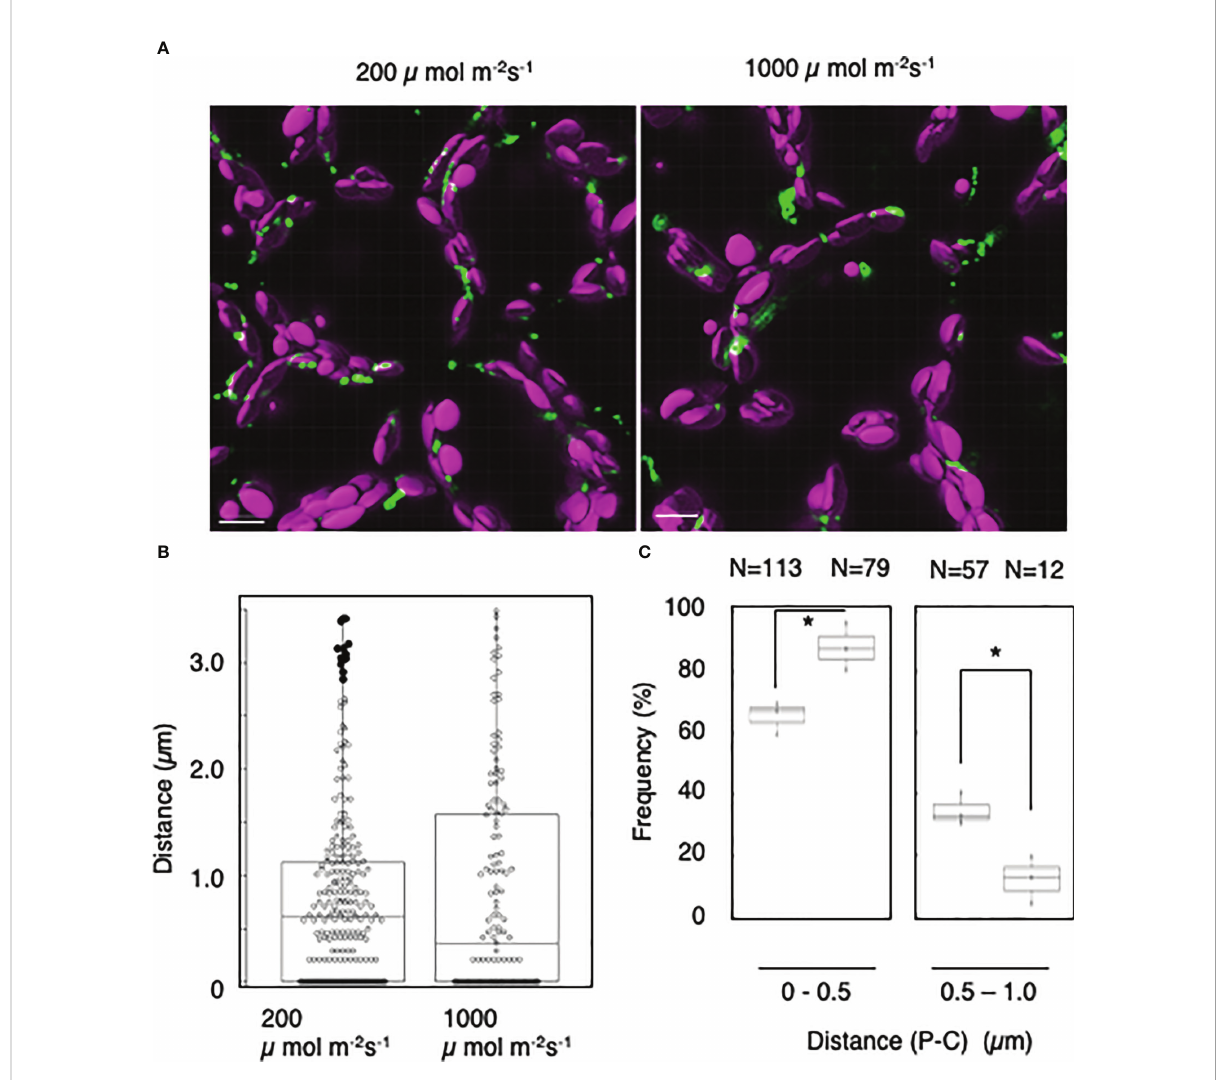
FIGURE 5 Measurement of the distances between chloroplasts and peroxisomes in leaf mesophyll cells under high-light conditions. (A) Representative images of chloroplasts (magenta) and peroxisomes (green) in leaf mesophyll cells adapted to low-intensity (200 µmol m − 2 s − 1 , left) and high- intensity (1,000 µmol m − 2 s − 1 , right) light for 2 h. Bars, 10 µm. (B) Box plots of the distances between peroxisomes and chloroplasts in (A) . The average distance was 0.79 ± 0.84 µm (n = 252) in 200 µmol m − 2 s − 1 light and 0.829 ± 1.01 µm (n = 143) in 1,000 µmol m − 2 s − 1 light from fi ve cells. The median was 0.62 µm in 200 µmol m − 2 s − 1 light and 0.37 µm in 1,000 µmol m − 2 s − 1 light. Frequency of the distances between peroxisomes and chloroplasts in (A) . The frequency of distances of 0 – 1.0 µm between peroxisomes and chloroplasts. Bars, 10 µm. (C) The frequency of distances of 0 – 0.5 µm between peroxisomes and chloroplasts in 200 µmol m − 2 s − 1 and 1,000 µmol m − 2 s − 1 light was 65.6 ± 5.38% (n = 113) in the dark and 88.1 ± 7.85% (n = 79) in the light, whereas the frequency of distances of 0.5 – 1.0 µm was 34.5 ± 5.38% (n = 57) in the dark and 12.0 ± 7.85% (n = 12) in the light in (B) . * P < 0.01, Student ’ s t